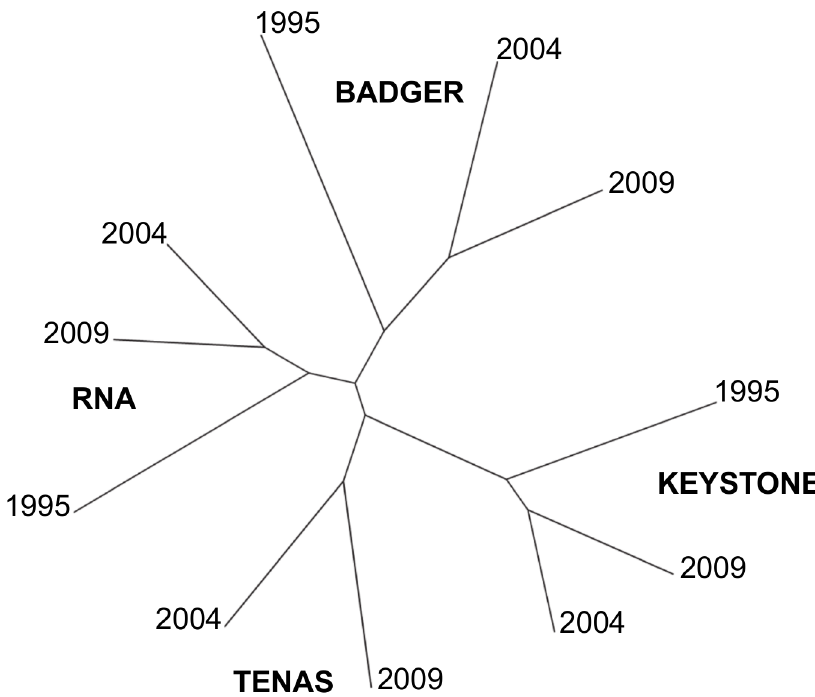
Figure 2. Neighbor-joining tree showing genetic relationship among Thompson clover. Relatedness of four populations of Thompson clover sampled in 1995, 2004, and 2009, based on Nei’s genetic distance estimated using AFLPs.